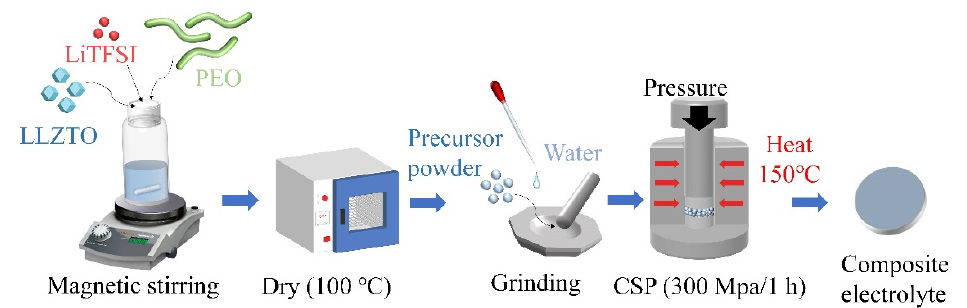
Figure 7. Schematic illustration of cold sintering to produce composite electrolytes comprised of ceramics and polymers. ceramics and